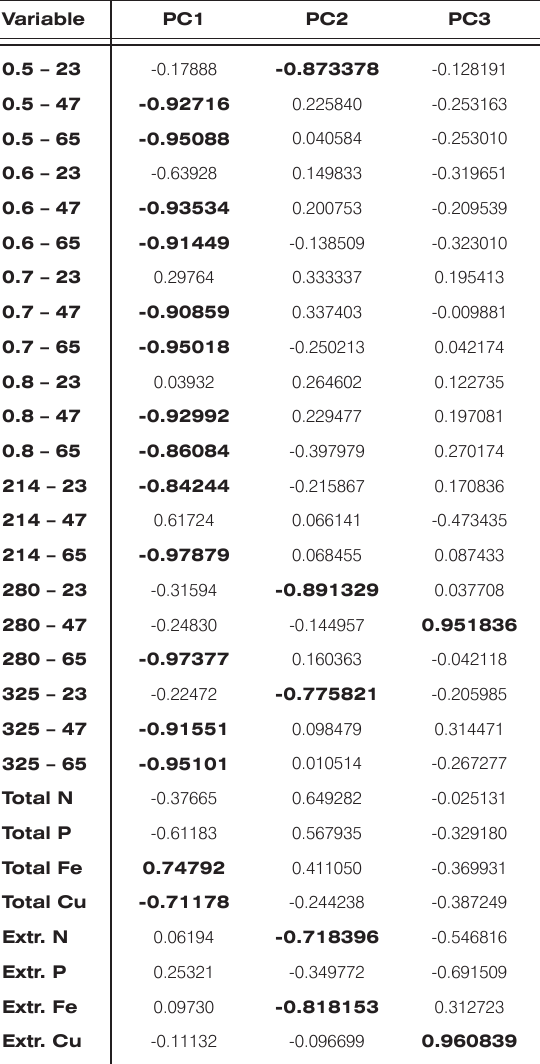
Loadings for first 3 components obtained for all data set (70×29). The loadings with values higher than 0.7 are in bold Variable